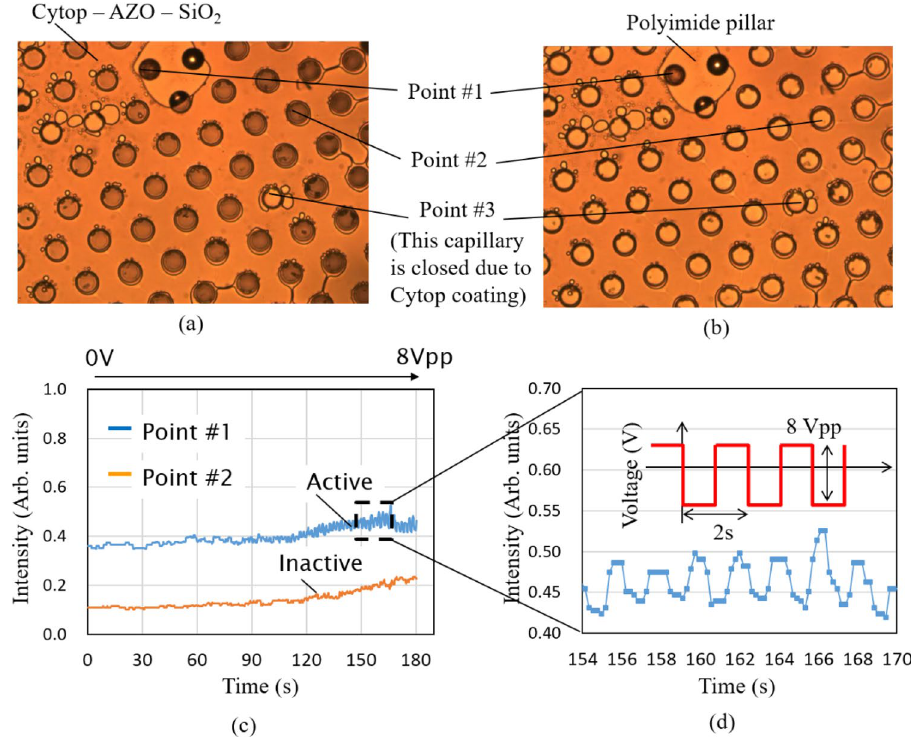
Figure 6. Evaluation results. ( a ) Without voltage supply. ( b ) With voltage supply. ( c ) Quantitative evaluation. ( d ) Liquid